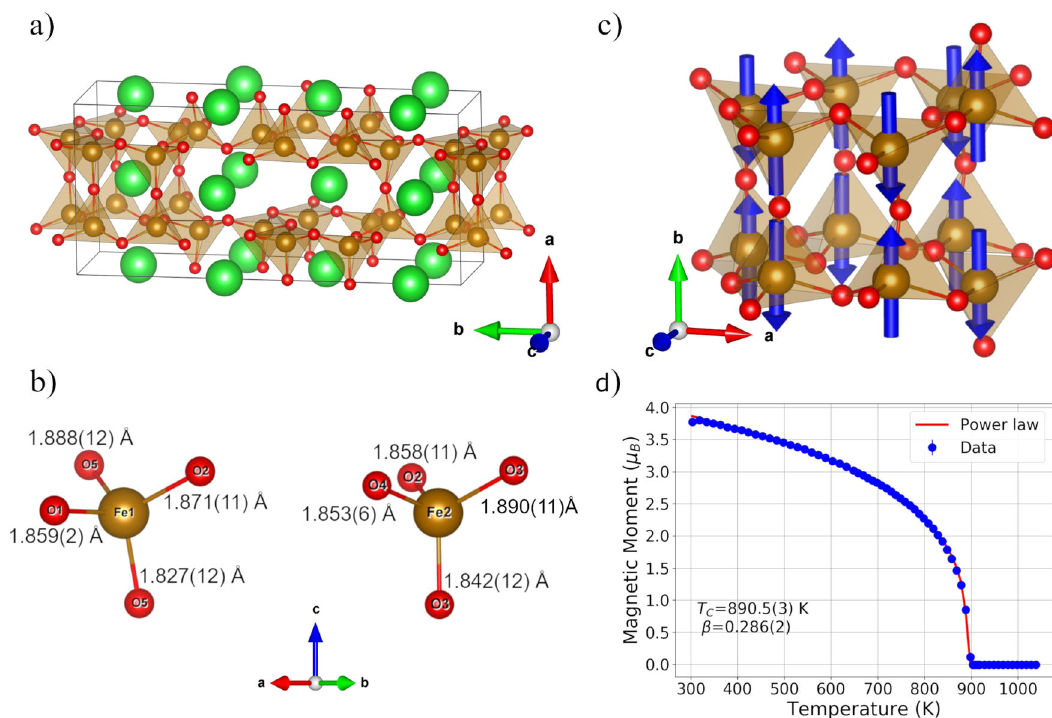
Fig. 1 | γ -BaFe 2 O 4 crystaland magnetic structures.a Projection of the γ -BaFe 2 O 4 nuclear structure obtained from the single crystal X-ray data. Green spheres represent the barium ions whereas orange and red spheres represent iron and oxygen, respectively. The projection shows the UUUUUD pattern of FeO 4 tetra- hedra within the triangular cavities running along the [100] direction. b CoordinationpolyhedraforthetwoindependentFepositions.TheaverageFe — O bond lengths are 1.861(9) and 1.861(10)Å for Fe1 and Fe2 respectively, compatible